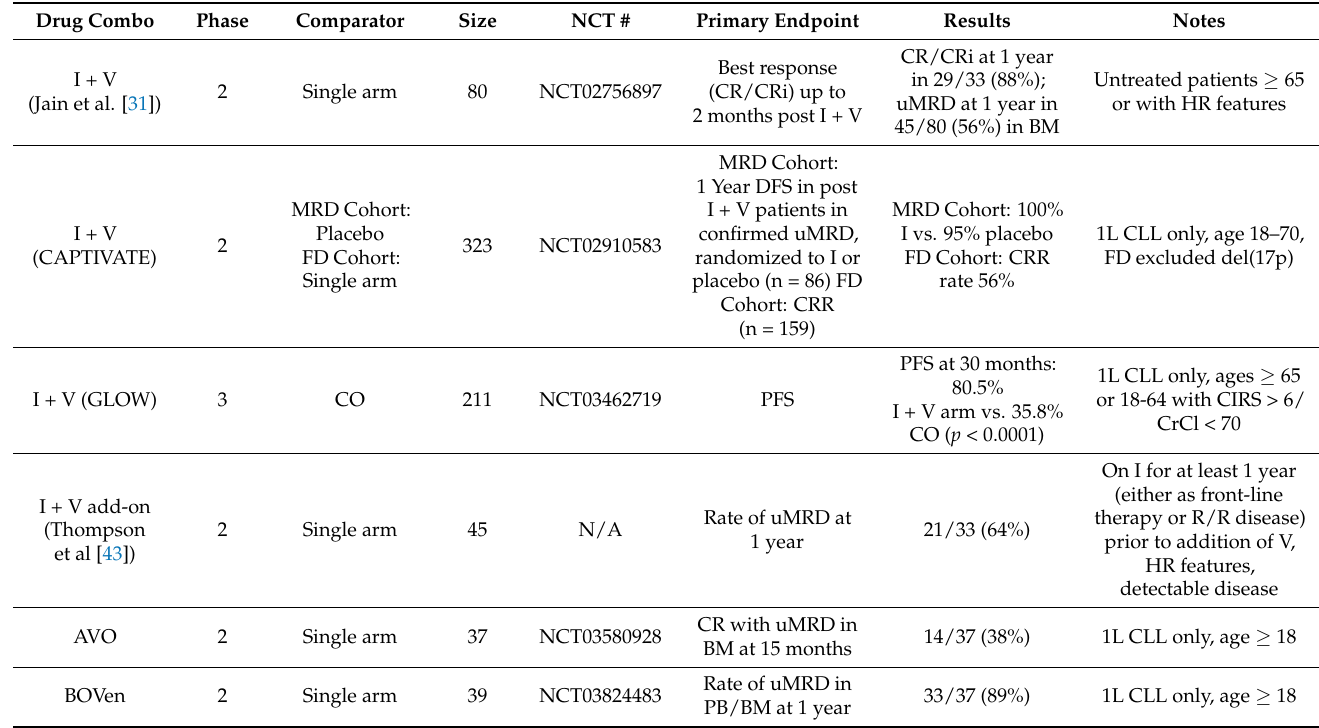
Table 2. A summary of key information from novel–novel trials in